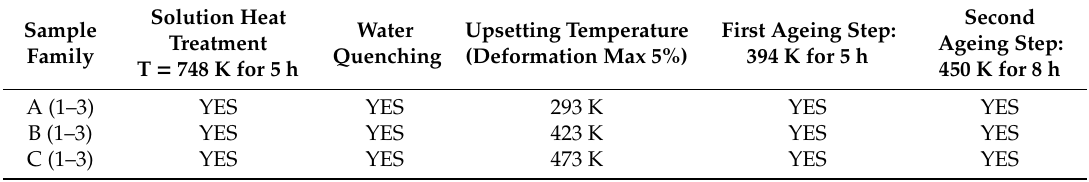
Table 2. Modified heat treatment cycles for the AA7050